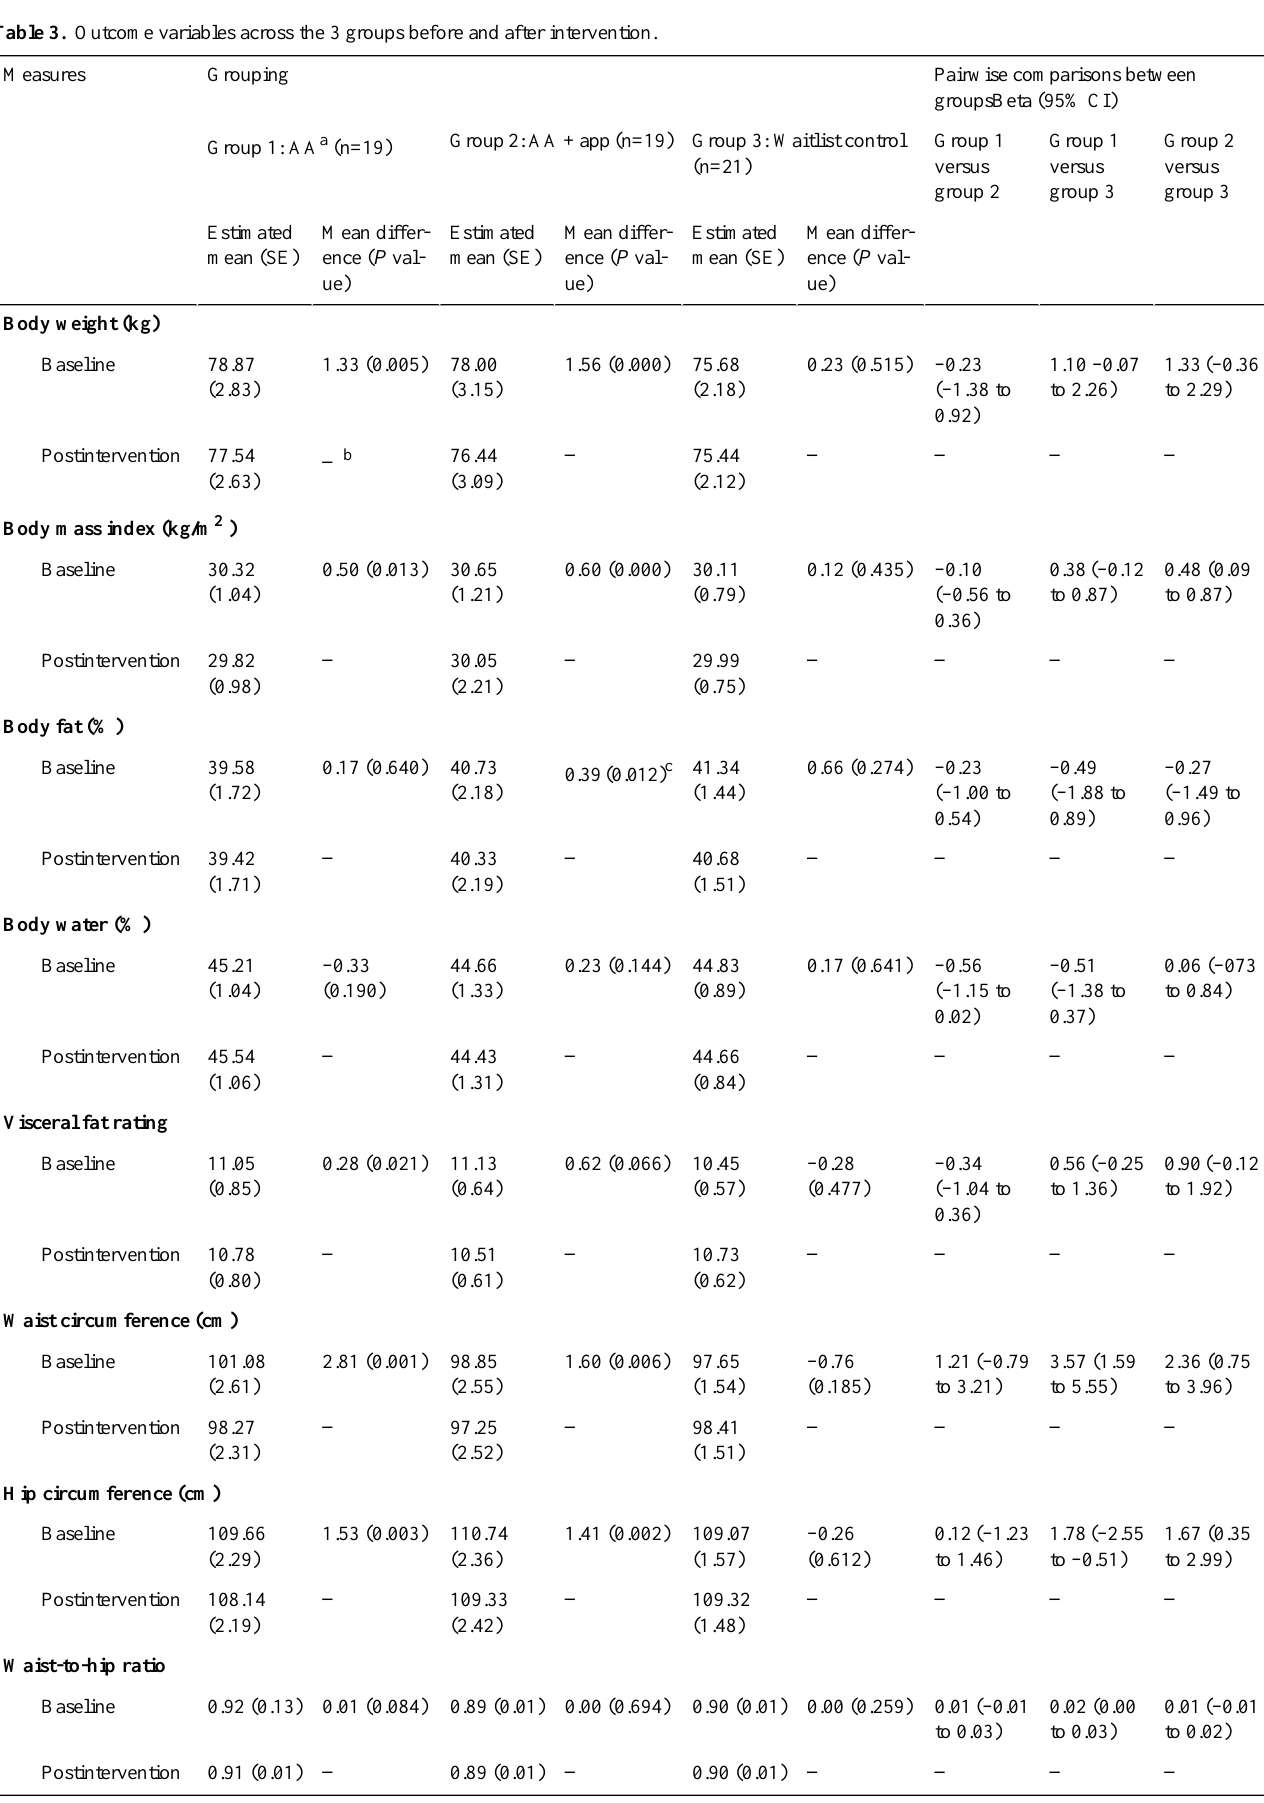
Table 3. Outcome variables across the 3 groups before and after